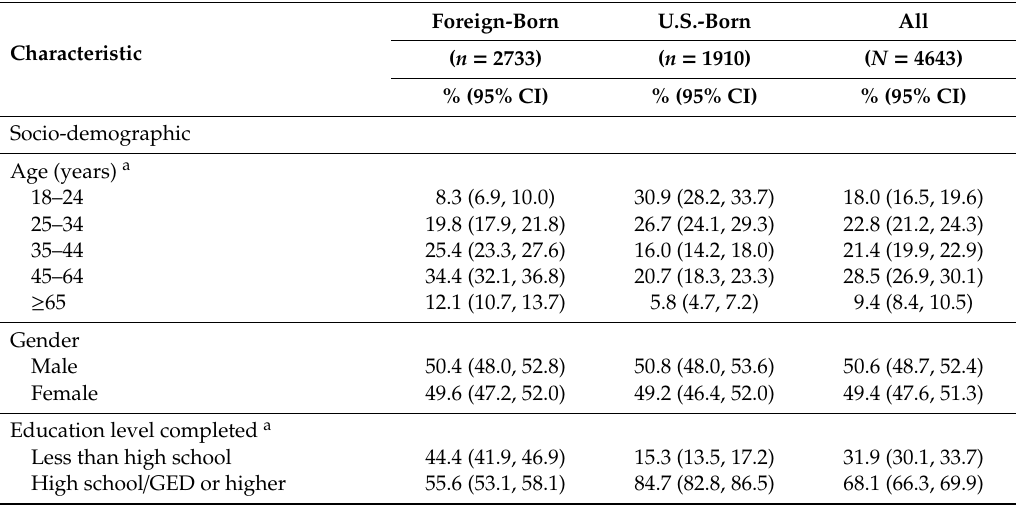
Table 1. Weighted characteristics of Latino sample by nativity and overall, the NHIS 2015.